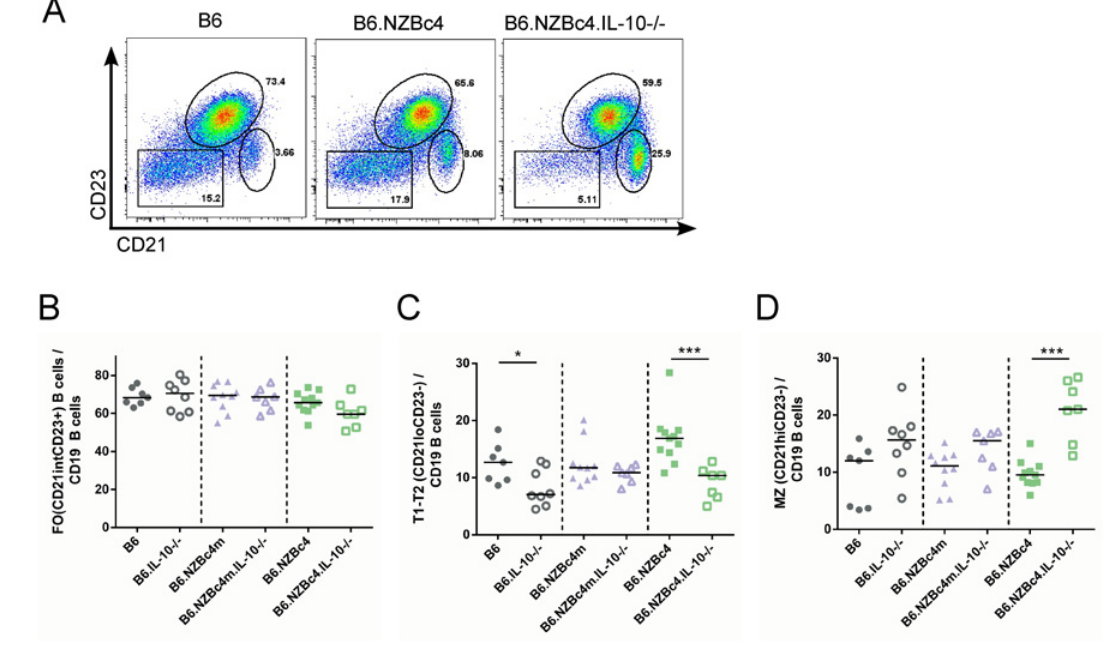
Fig 5. Knockout of IL-10 in full-length B6.NZBc4 but not B6.NZBc4m mice resulted in a loss of transitional B cells and an expansion of marginal zone B cells. (A) Representative gating of transitional (CD21 lo CD23 - ), follicular (CD21 int CD23 + ), and marginal zone/marginal zone precursor (CD21 hi CD23 - ) B cells from 4 month old mice. Frequencies of splenic B cell subsets were measured by flow cytometry. (B,C,D) The frequency of follicular, transitional and marginal zone B cells, respectively, was measured by flow cytometry as gated in (A). Each point represents a single mouse, with the lines for each group representing the median. Statistical analyses were carried out using a Mann-Whitney U test between homozygous and IL-10 knockout animals of the same genetic background. * P < 0.05, ** P < 0.01, *** P < 0.001.